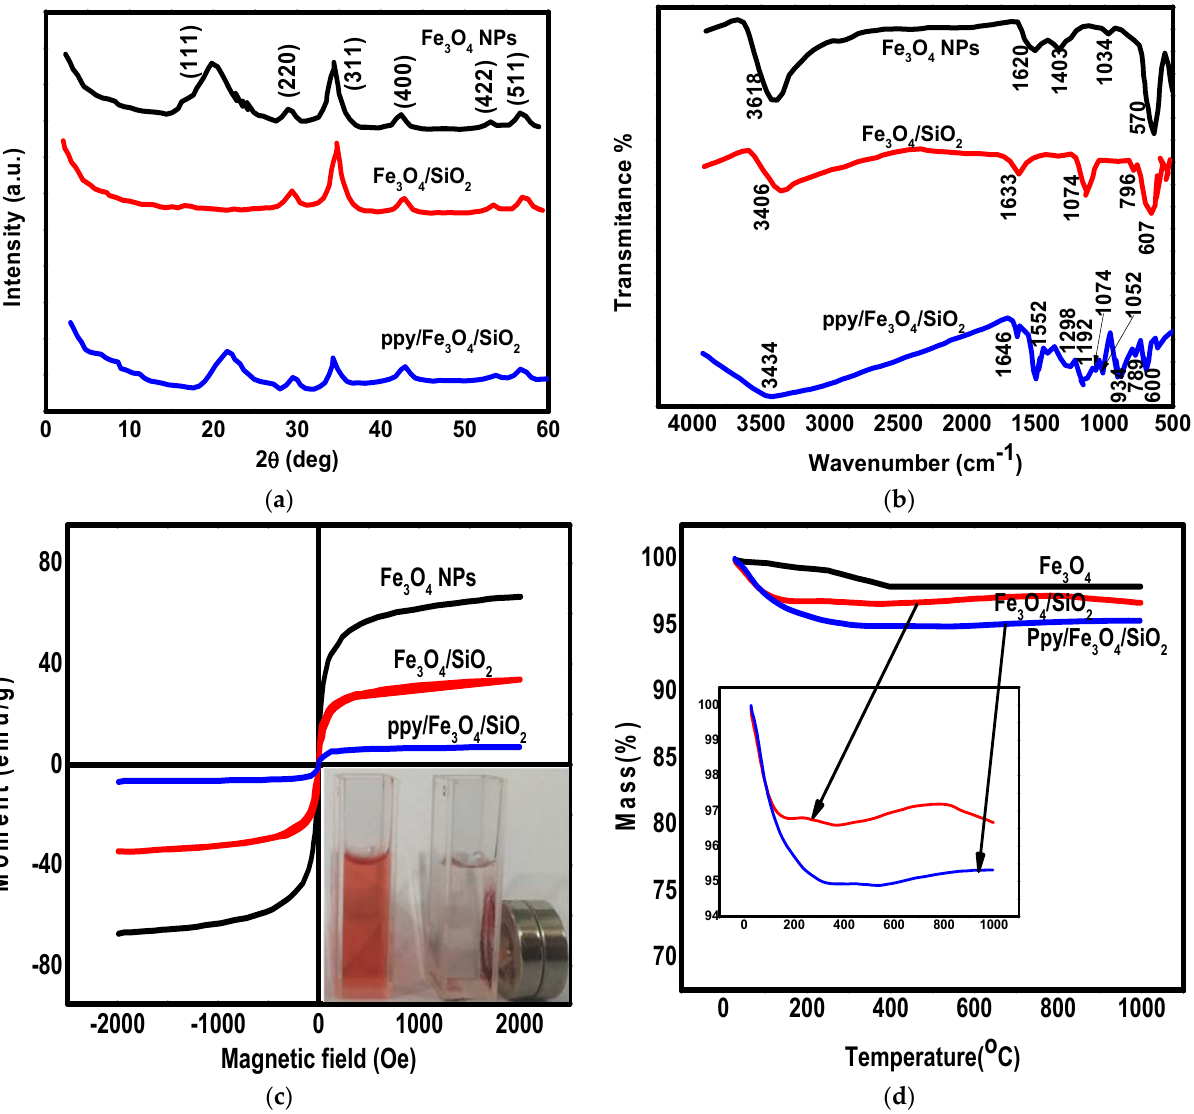
Figure 1. XRD ( a ), FT-IR ( b ), magnetization curves ( c ) (inset: separation of magnetic nanocomposite after adsorption with an external magnet), and thermogravimetric analysis (TGA) ( d ) of synthesized Fe 3 O 4 nanoparticles, Fe 3 O 4 /SiO 2 nanocomposite, and PPy/Fe 3 O 4 /SiO 2 nanocomposite.